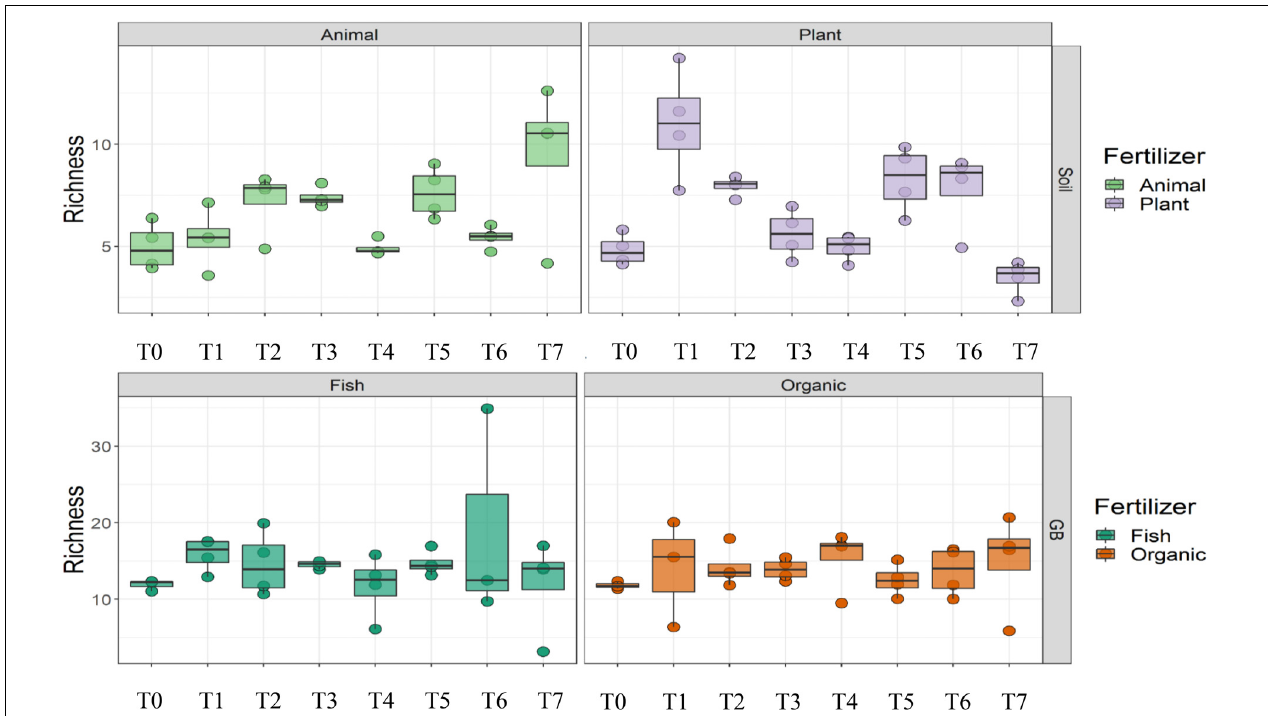
FIGURE 6 | Culture system impacted bacterial community characteristics and showed opposite trends. Richness followed the oscillatory trend in soil (upper panel) but not in growing medium (lower panel) . Samples for microbial community analysis were taken at 8 different timepoints, i.e., 55 DAS (T0), 68 DAS (T1), 83 DAS (T2), 113 DAS (T3), 146 DAS (T4), 172 DAS (T5), 221 DAS (T6), and 321 DAS